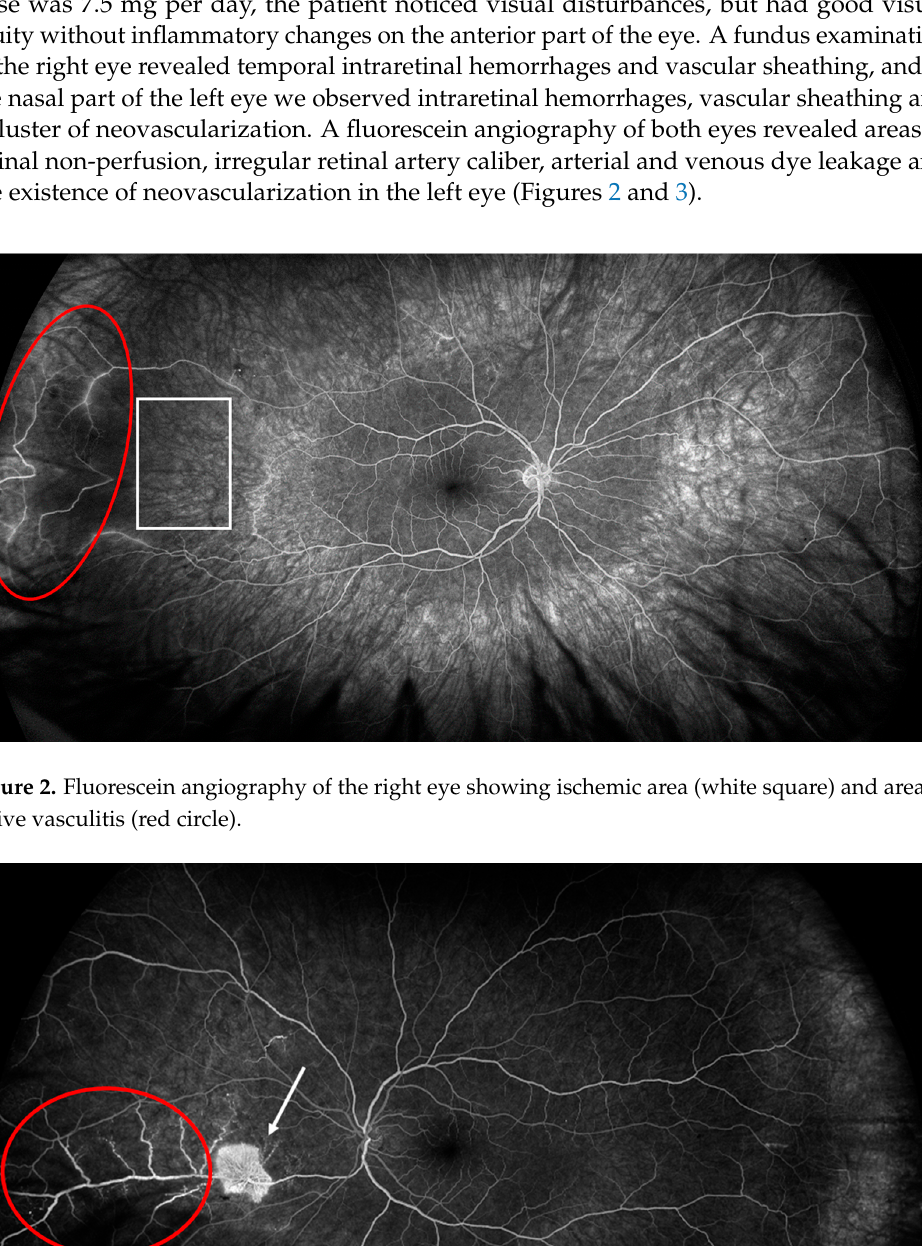
Figure 1 . Fundoscopic examination of the right eye showing retinal vasculopathy with hemorrhages (arrows) and cotton wool exudate (red circle).